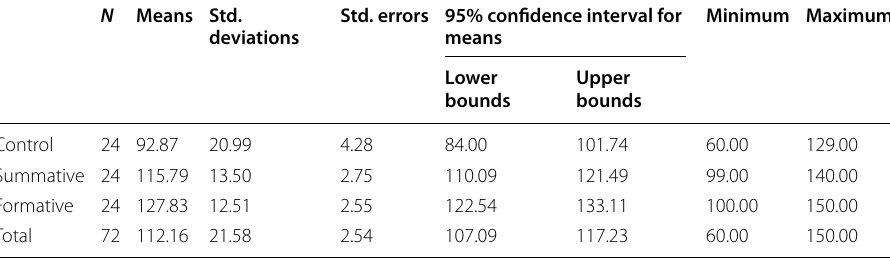
Table 13 Descriptive statistics of the three groups on the motivation post-tests N Means Std. deviations